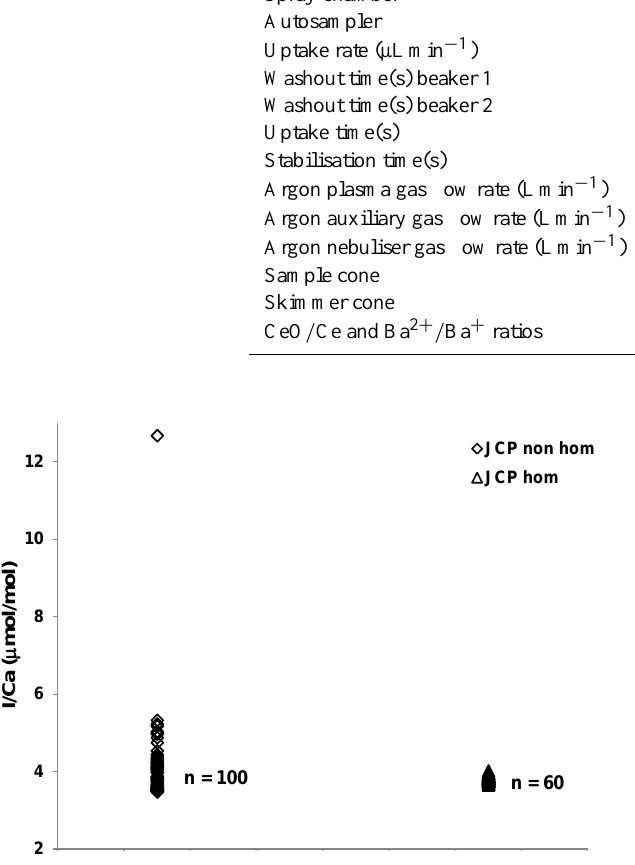
Figure 2. Comparison of all I / Ca measurements on the untreated JCp-1 and an aliquot of the same standard homogenised using a mortar. The mean precision for a single analysis for the aragonitic reference standards in this study was 1 σ mean = 1 . 5% ( n =